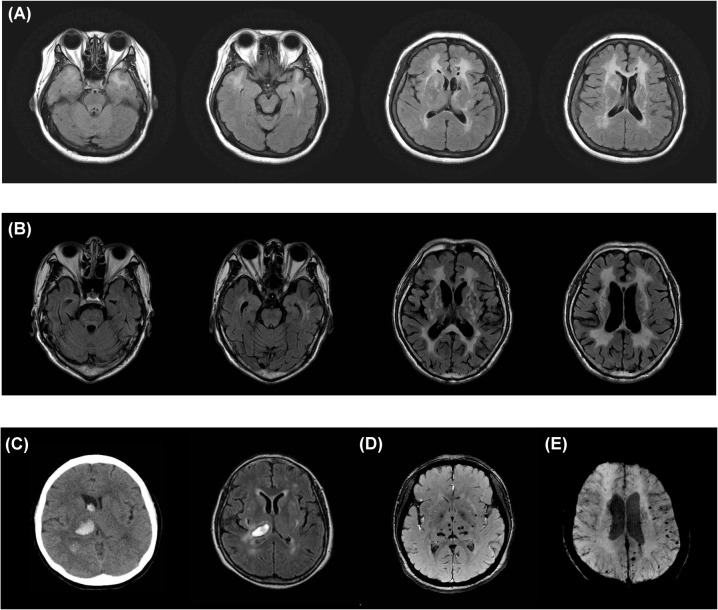
Representative neuroimaging of CADASIL patients.(A) Fluid-attenuated inversion recovery (FLAIR) images from a 54-year-old patient with NOTCH3 R110C mutation showing diffuse white matter lesions (WMLs) with significant involvement of external capsules and anterior temporal pole. (B) FLAIR images from a 62-year-old patient with NOTCH3 R544C mutation showing diffuse WMLs without significant involvement of anterior temporal pole. (C) Brain computer tomography and T2 weighted images from a 55-year-old patient with NOTCH3 R544C mutation showing diffuse WMLs and an intracerebral hemorrhage (ICH) in the right thalamus on the second and eighteenth day, respectively, after the occurrence of ICH. (D) Susceptibility-weighted angiography (SWAN) images from a 48-year-old patient with NOTCH3 R427C mutation showing multiple cerebral microbleeds in the thalami and basal ganglia. (E) SWAN images from a 53-year-old patient with NOTCH3 R544C showing multiple cerebral microbleeds in the subcortical regions.